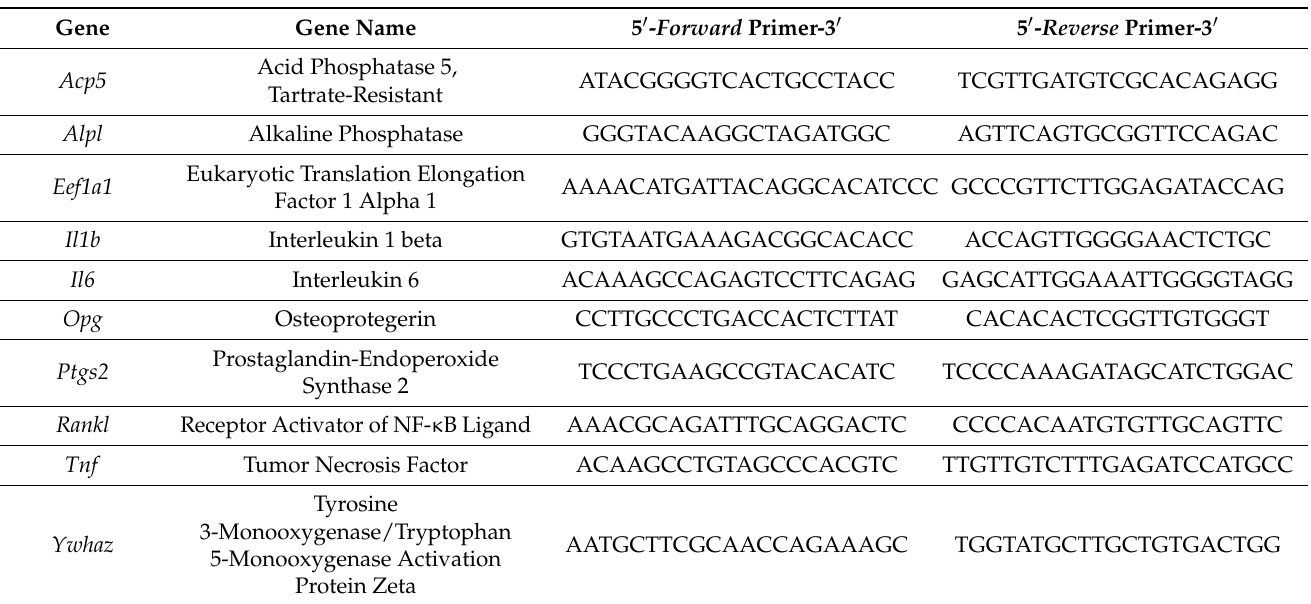
Table 1. Primer sequences of used reference ( Eef1a1/Ywhaz ) and target